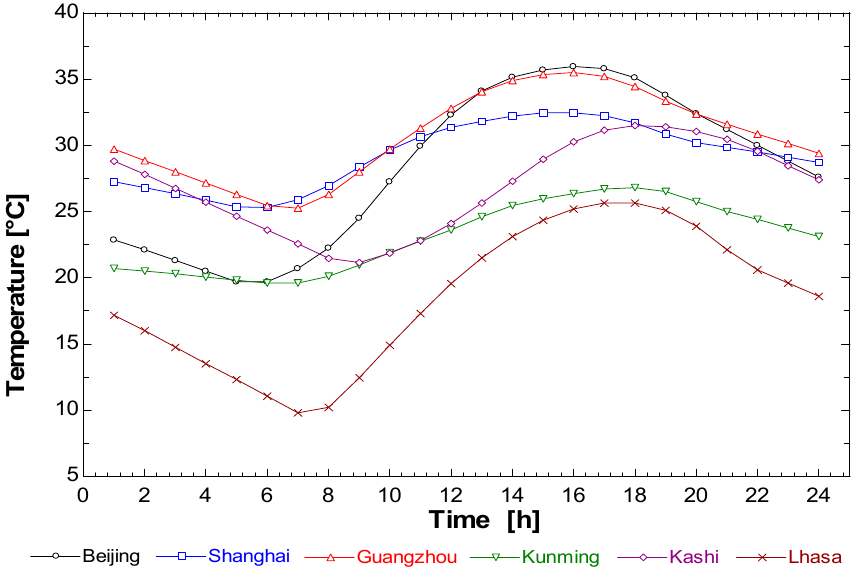
Figure 8. Comparison of temperatures of each selected city.